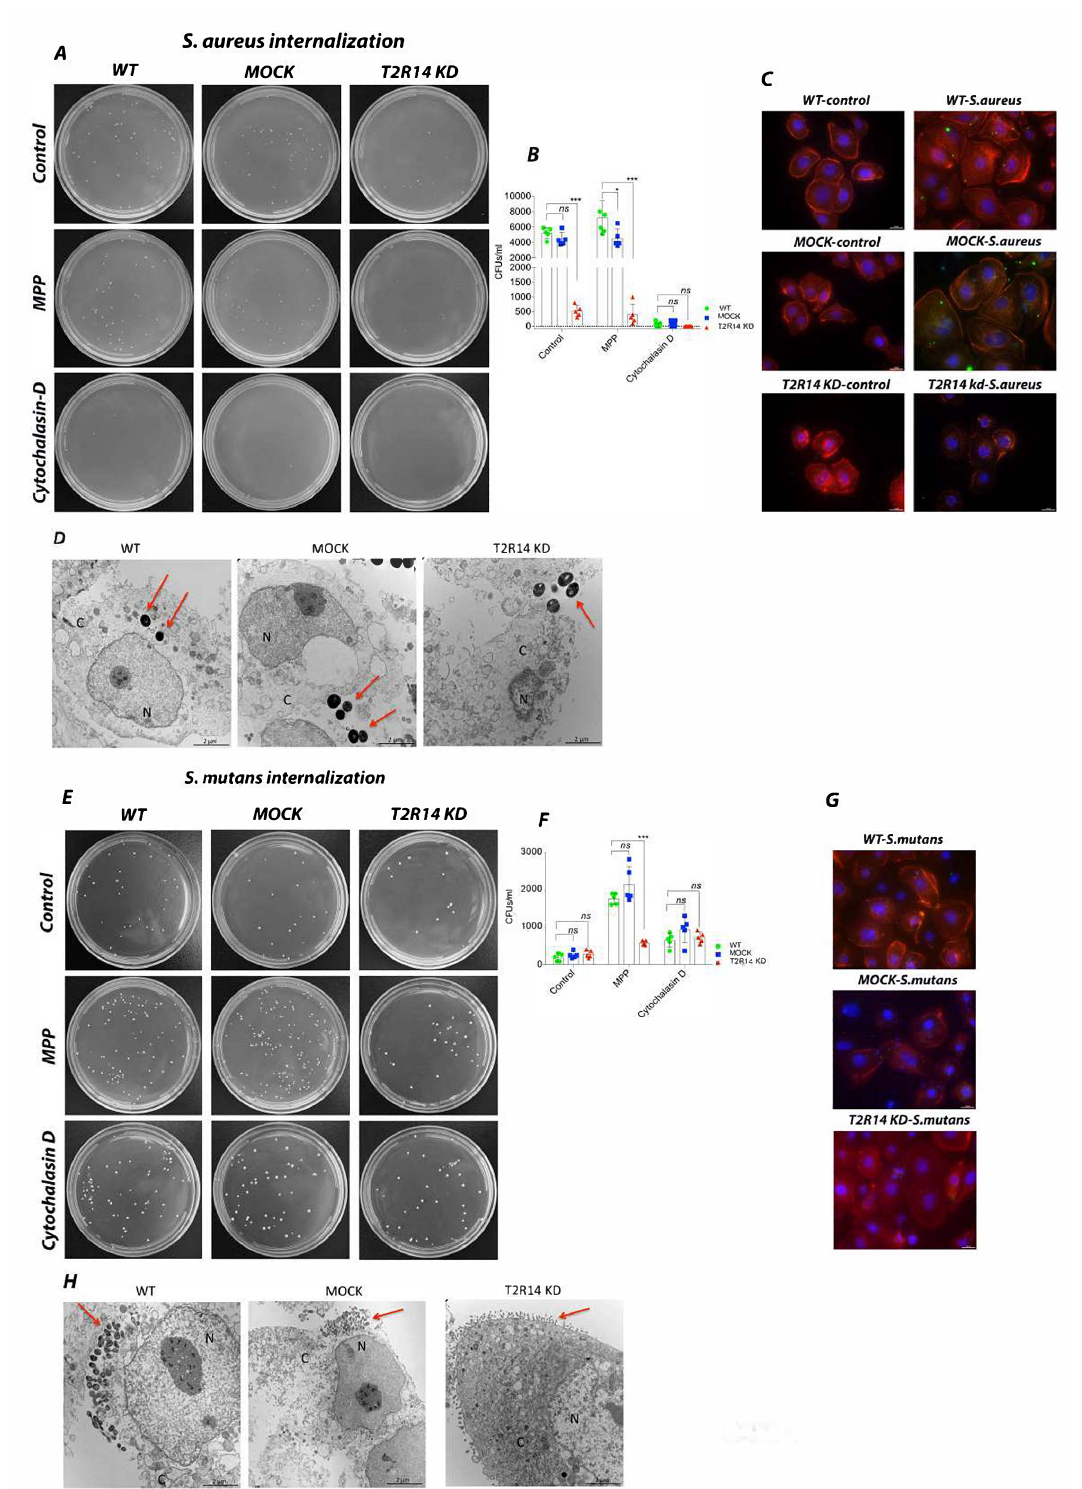
Figure 1. Internalization of S. aureus and S mutans in OKF6 WT, MOCK and T2R14 KD cells. ( A ) Representative LB agar plates depicting S. aureus colonies that are internalized in OKF6 WT, MOCK and T2R14 KD cells pretreated with MPP (5 µ M) and cytochalasin D (1 µ g/mL). A total of 100 µ L of the diluent containing bacteria was grown on LB agar plates for 24